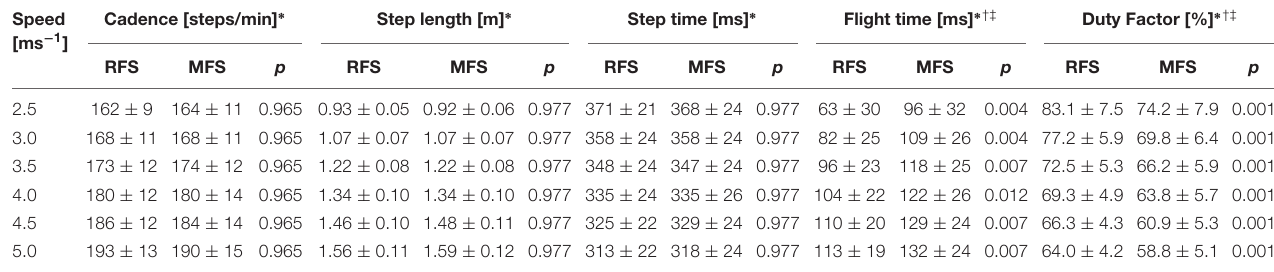
TABLE 1 | Mean ± standard deviation of the cadence, step length, step time, flight time, and duty factor for the rearfoot strikers ( n = 31) and mid-forefoot strikers ( n =